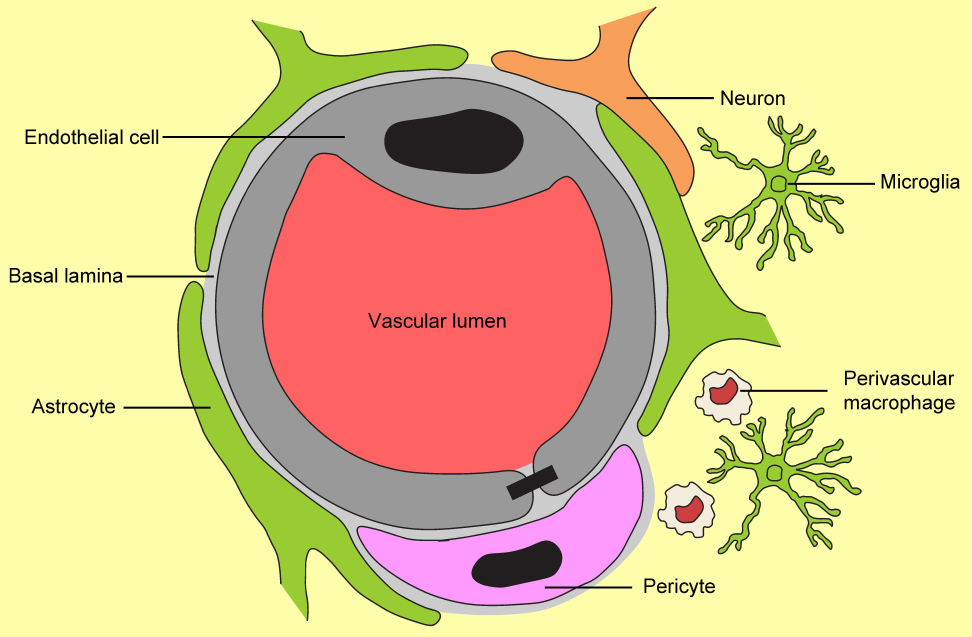
Figure 2. Schematic representation of the blood-brain barrier in mammals in the context of the neu- rovascular unit. Cross-section of a mammalian BBB with associated components of the neurovascular unit (NVU). Mammals have an endothelial barrier with tight junctions (black bar) between the en- dothelial cells. The function of the BBB depends upon the synergistic interaction of the many cellular components that make up the NVU. Astrocytes, pericytes, neurons, microglia, and perivascular macrophages can modulate the permeability of the BBB via direct contact and/or via release of paracrine factors such as cytokines. Image adapted from